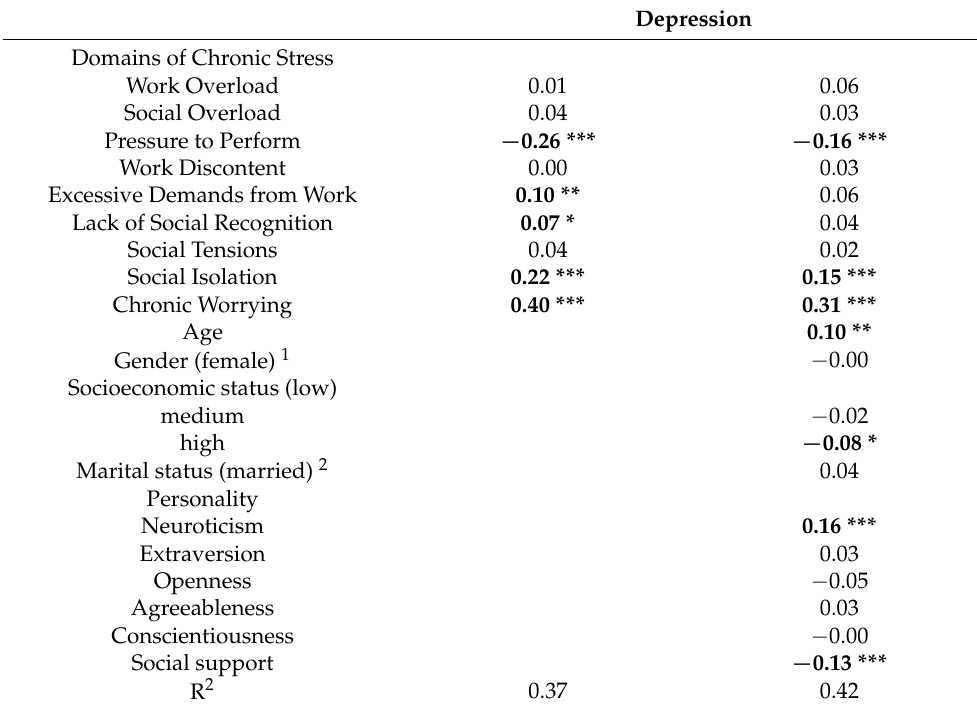
Table 3. Prediction of depression by areas of chronic stress with and without control variables (stan- dardized regression coefficients; N = 1008).